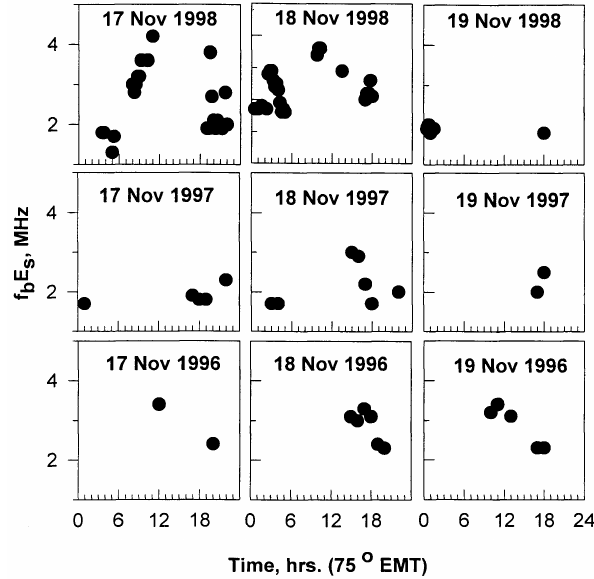
Fig. 3. Daily variations of f 0 E s over Ahmedabad for the period 17 to 19 November for the years 1996–98 plotted from the quarter hourly data.